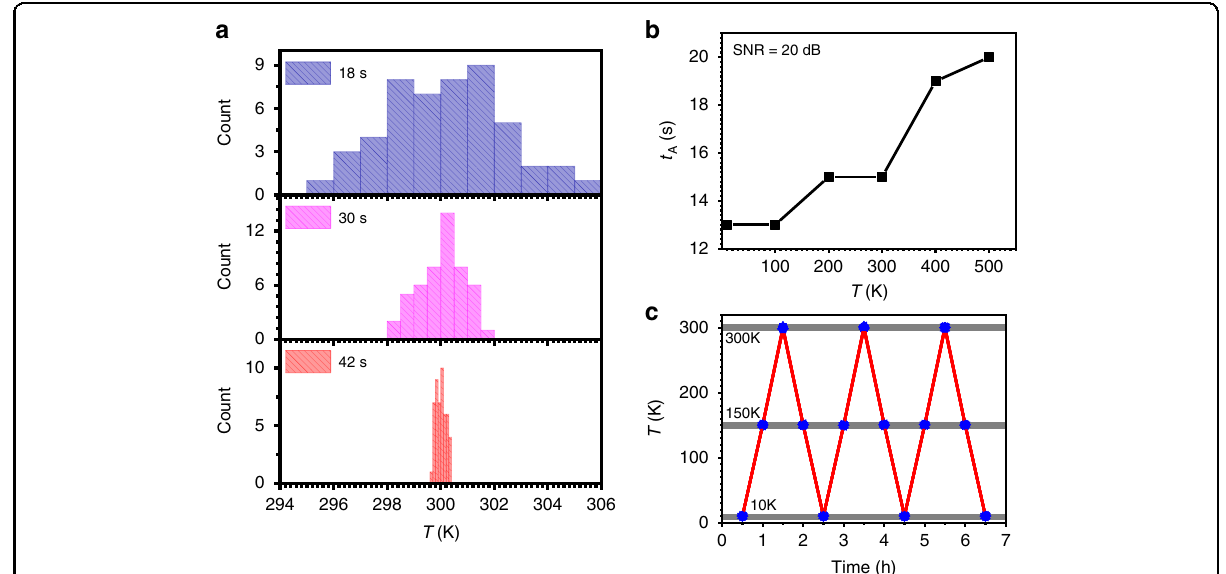
Fig. 4 Acquisition time, resolution/SNR, and the measurement repeatability of a single ECS NW thermometer. a Measurement effect of target temperature 300 K with different acquisition time, b necessary time needed to reach SNR of 20 dB at different temperatures, and c repeatability test for three cycles with long working hours of our ECS NW